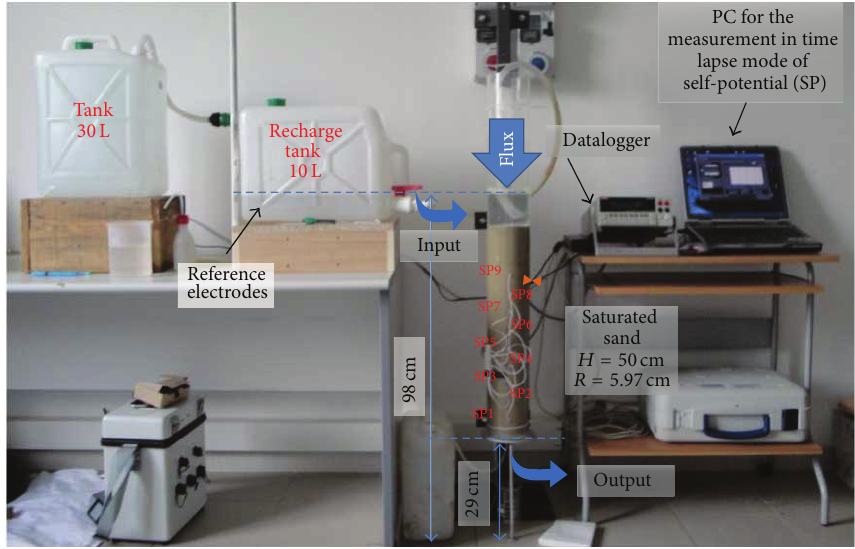
Figure 2: Experimental column facility installed at the Hydrogeosite Laboratory of CNR-IMAA (Marsico Nuovo, Italy).